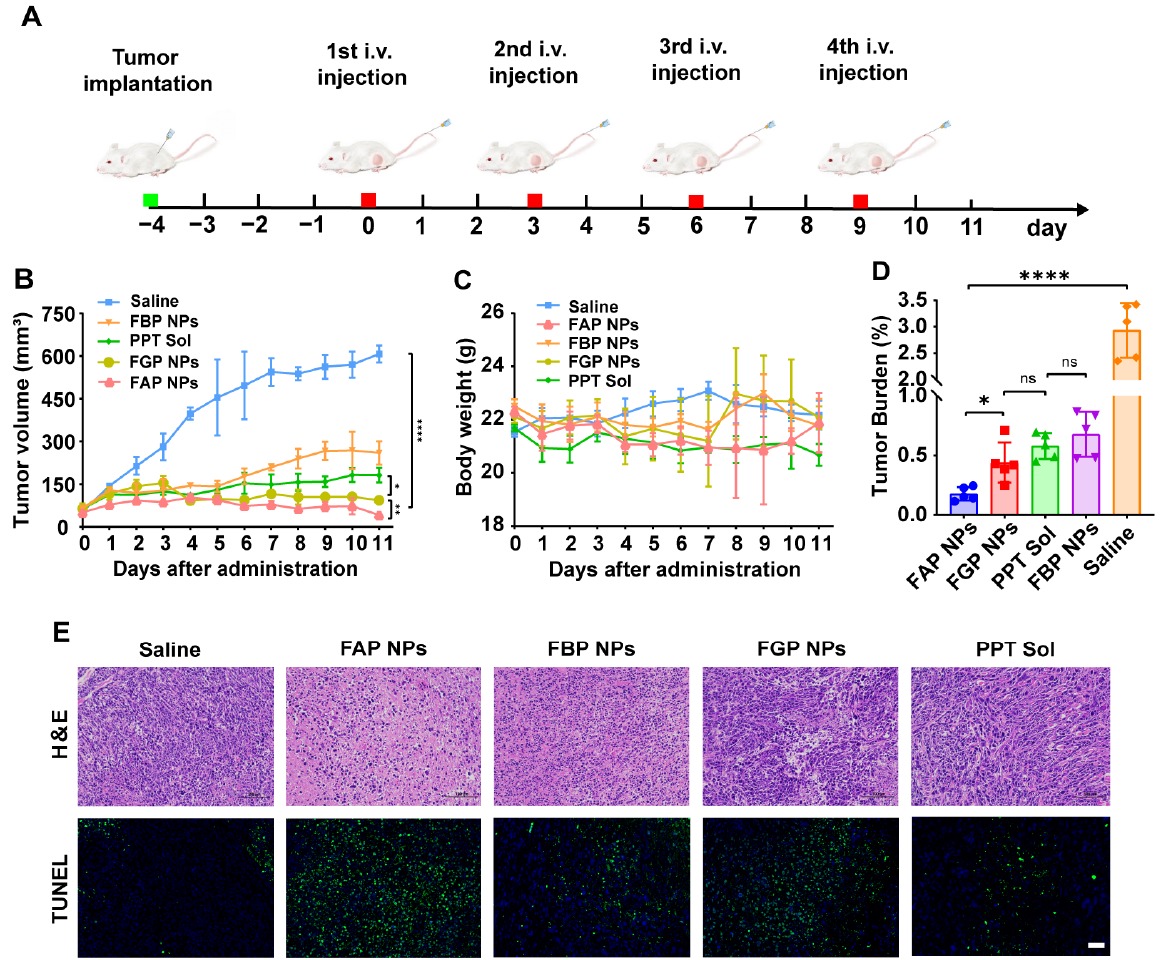
Figure 8. In vivo antitumor efficacy of prodrug NPs against 4T1 xenograft tumors. ( n = 5) ( A ) Schematic diagram of experimental process, ( B ) tumor volume, ( C ) body weight changes and ( D ) tumor burden. * p < 0.05, ** p < 0.001, **** p < 0.0001, n.s. no significant. ( E ) H&E staining and TUNEL assay images of tumor sections after the last treatment. Scale bar = 50 µ